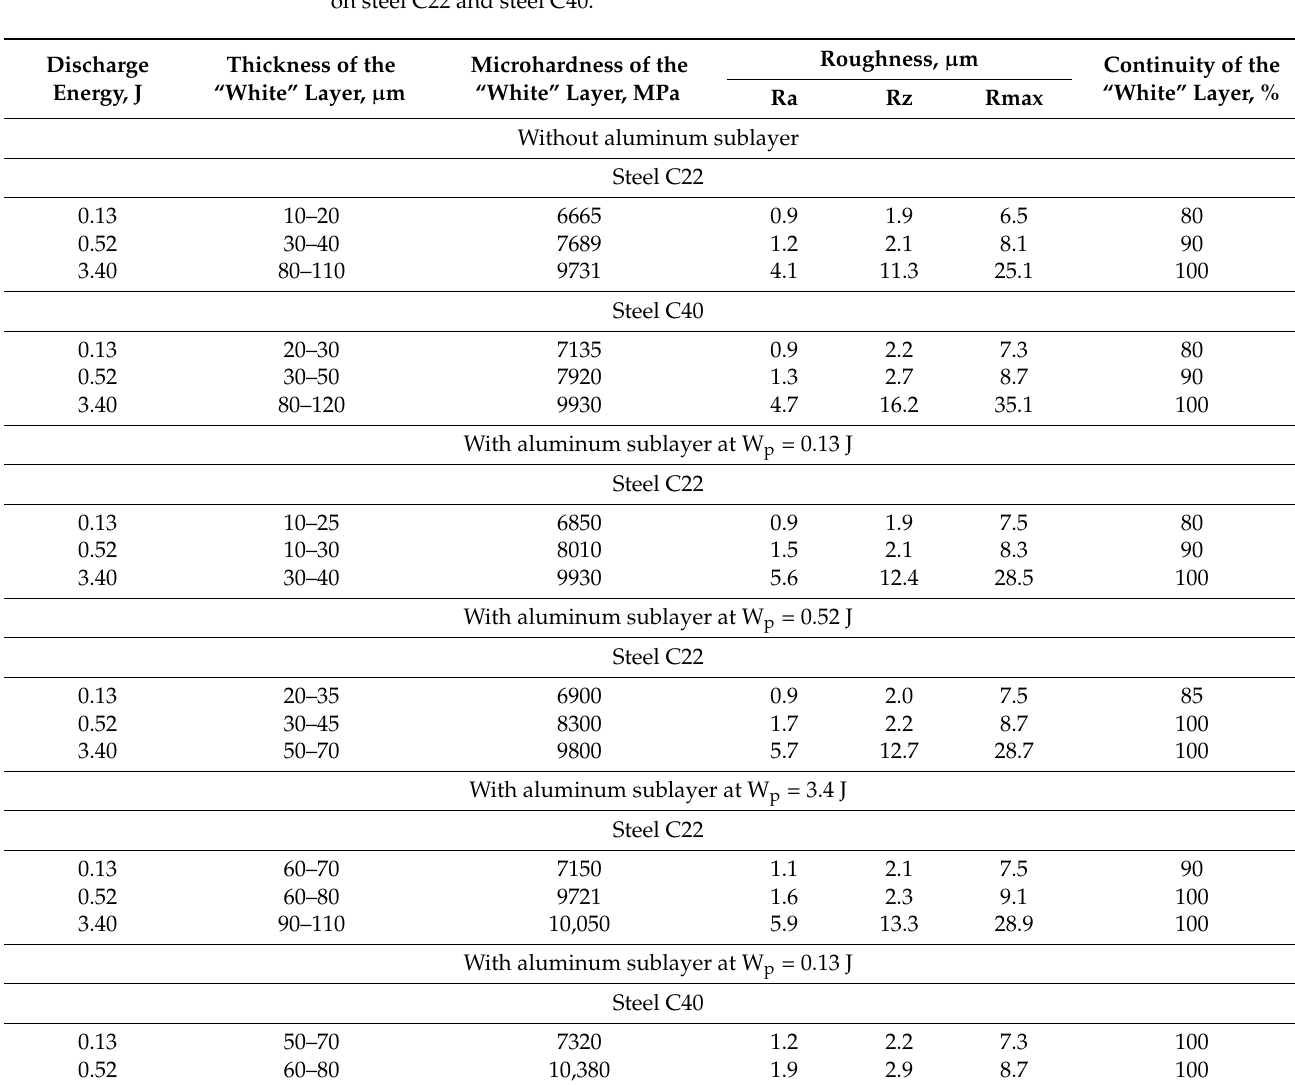
Table 2. The qualitative parameters of the nitrocarburized (N + C) layers obtained by the ESA method on steel C22 and steel